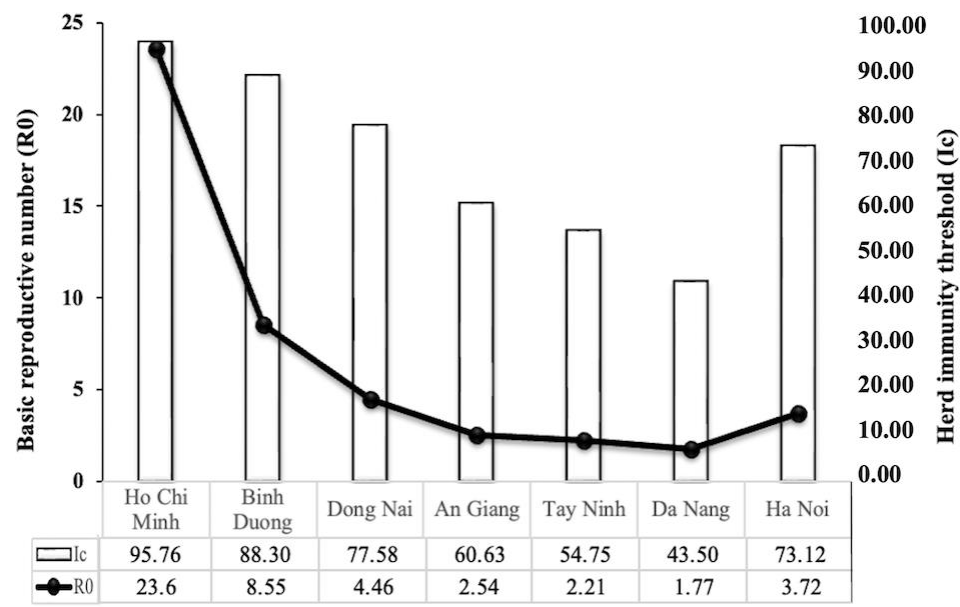
Figure 4. Herd immunity threshold (Ic-%) of COVID-19 depending on different values of the basic reproductive number (R 0 ).